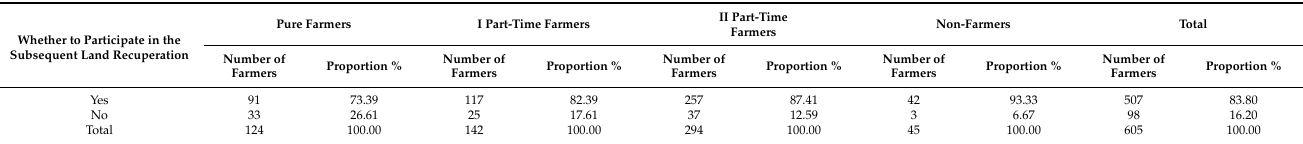
Table 3. Subsequent land recuperation intention of different types of